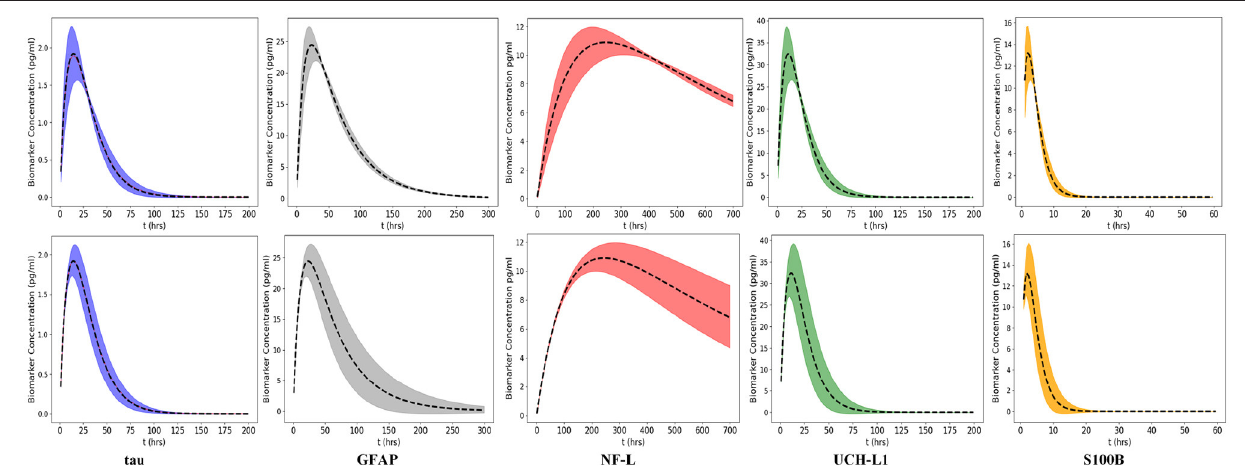
FIGURE 7 | Uncertainty propagated in the model output caused by variation of two input parameters k a and k e . The uncertainty bands are the 2 δ uncertainty of the model output ( δ is the standard deviation of the model output). Variations in k a and k e are derived from the lognormal probability distributions (defined by Equation 7), the standard deviation is 0.2 (Top) Model output uncertainty due to k a . (Bottom) Model output uncertainty due to k e . Peak of each curve corresponds to C max at T max . Curve up to T max is absorption phase and curve after T max is elimination phase. Uncertainty in k a dominates absorption phase whereas uncertainty in k e dominates the elimination phase for all biomarkers. Time intervals of greatest uncertainty depend on the specific values of k e and k a . Note that the x-axis has been expanded or compressed depending on the half-life of the biomarker. Confidence limits provide insight as to when the uncertainty about k a or k e causes greatest uncertainty about biomarker level C p .